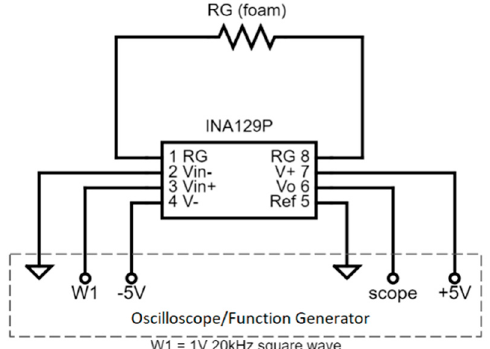
Figure 5. Schematic of sensor connection to oscilloscope/function generator for resistance measure- ments.